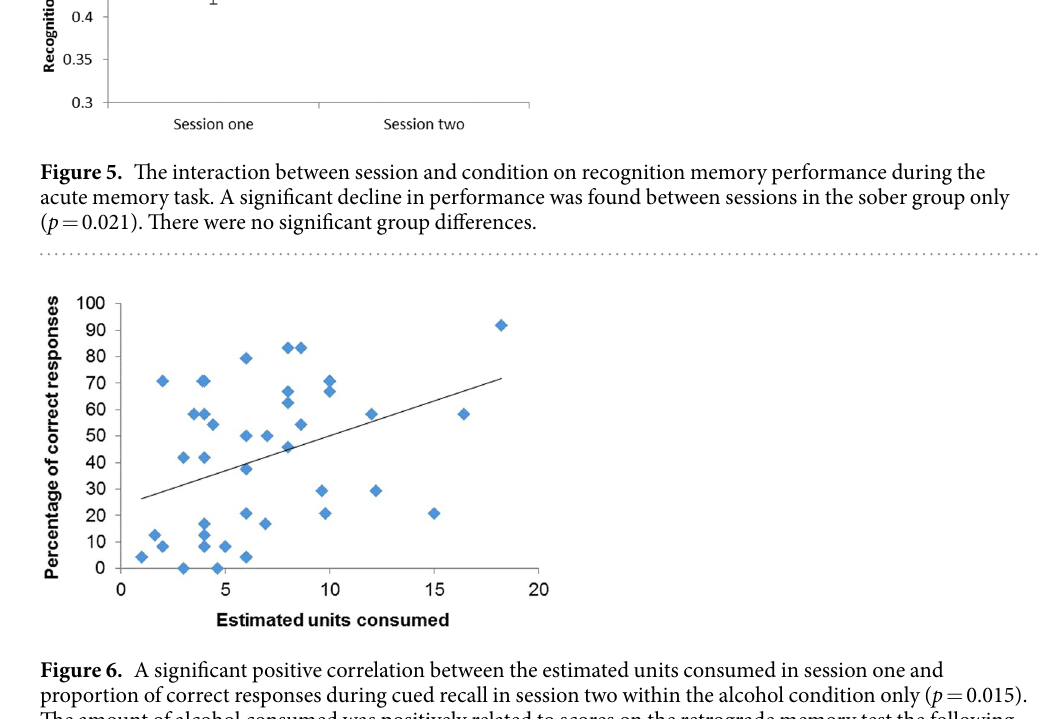
of alcohol consumption in environments where alcohol is frequently consumed, which is important for advising public health interventions. Rather than the wholly negative effect that alcohol is presumed to have on memory, this study suggests that there may be some subtle enhancing effects, that may be informative in future for devel- oping novel pharmacotherapies and tailored cognitive enhancing interventions. Clearly, from a public health perspective, the communication of these subtle and highly constrained positive effects of alcohol on memory should be carefully considered in the context of the wide-ranging longer term cognitive impairments associated with frequent heavy consumption of this drug. Performance on the memory anterograde task revealed a decline in performance of the sober group from ses- sion one to session two. There was not a significant increase in performance in the alcohol group across the two sessions, which might have been expected considering the acute memory impairing effects of alcohol. It may be